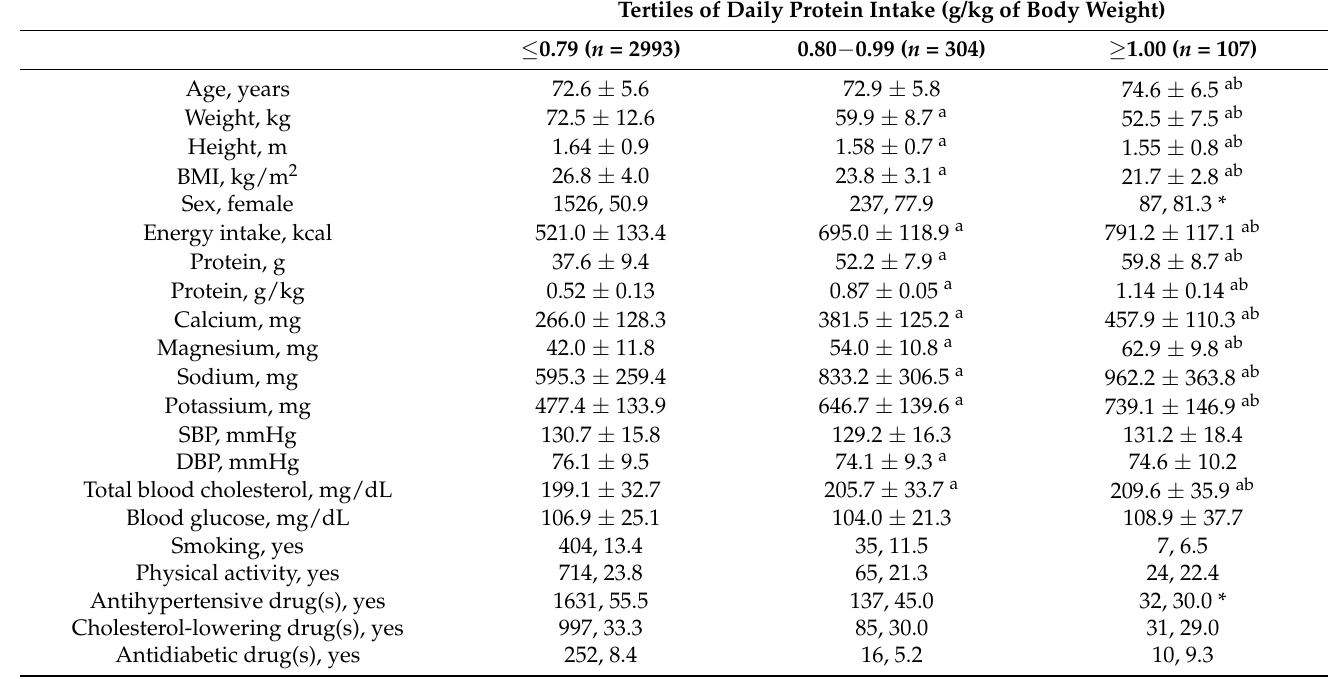
Table 2. Main characteristics of study participants according to tertiles of daily protein intake ( n = 3404). Tertiles of Daily Protein Intake (g/kg of Body